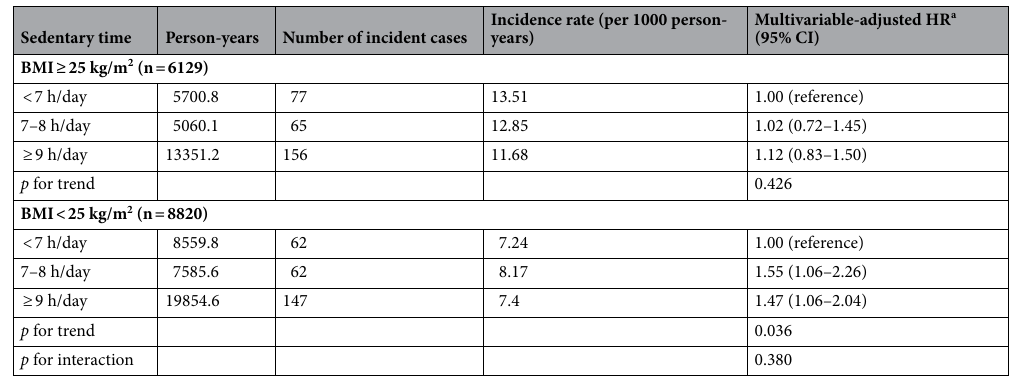
Table 3. Development of positive coronary artery calcium score (CACS) by sedentary time in obese and non- obese participants. BMI body mass index, CI confidence interval, HR hazard ratio. a Adjusted for age, alcohol intake, smoking status, regular exercise, BMI, systolic blood pressure, glucose, LDL, triglycerides, medication for dyslipideima, and hsCRP